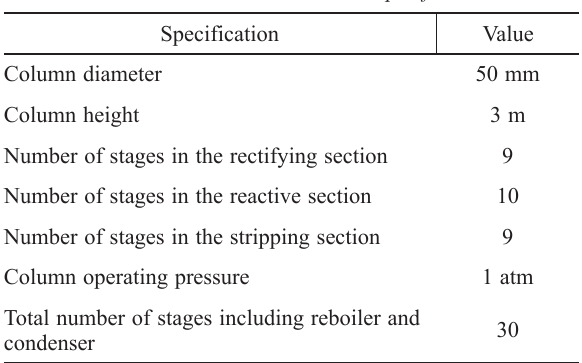
Table 2 – Reactive distillation column specifications